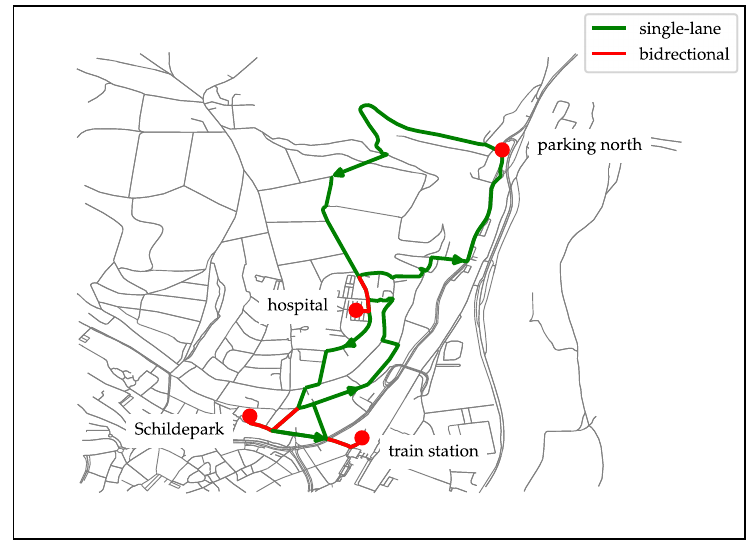
Figure 2. Stations and connecting graph of the proposed PRT system in Bad Hersfeld.